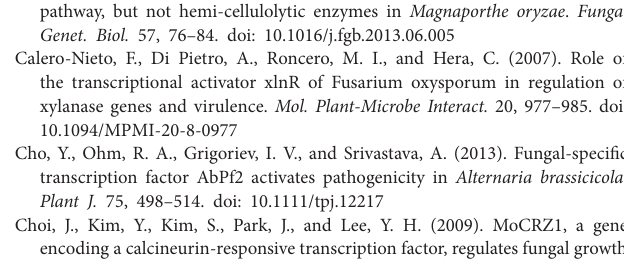
Supplementary Figure S1 | Distinct sites of the sequences predicted in transcriptomics and genomics of V. pyri . VP1G_03432 was characterized using V. pyri genomics. The sequence of VpxlnR was obtained from de novo transcriptomics. The line shown in the figure indicates the gaps of the two sequences. Supplementary Figure S2 | Constructs for VpxlnR replacement and complementation. VpxlnR deletion constructs were generated by triple joint PCR amplification (described in the “Materials and Methods” section). The arrows indicate primer sites. The numbers (1–12) represent the primers ( Supplementary Table S5 ) used for deletion construct generation and genomic PCR identification. Supplementary Figure S3 | The mutant was confirmed by genomic PCR and RT–qPCR. (A) Genomic PCR identification for fragments in replacement sites. Primer pairs with numbers are shown in the right panel, and numbers are the same as in Supplementary Figure S1 . WT, wild-type strain (Vp297); m-7 and m-56, VpxlnR deletion mutants; C-320 and C-236, VpxlnR complementation strains. (B) VpxlnR expression level in deletion mutant. Transcript levels were quantified by RT–qPCR and normalized to actin gene expression. Each test was repeat three times. The relative transcript level of the gene at time point 0 was set as 1.0. The data were analyzed using one-way ANOVA. ns indicates a value of p > 0.05, ** indicates a value of p < 0.01. Supplementary Figure S4 | RT–qPCR test of nontarget genes controlled by VpxlnR. (A) Serine/threonine-protein kinase KIN28-encoding gene (VP1G_04075); (B) serine/threonine-protein kinase GCN2-encoding gene (VP1G_10966); (C) putative phosphotransferase-encoding gene (VP1G_03516). The transcript level of each gene was normalized to actin expression. Each test was repeated three times, and the data were analysed using one-way ANOVA. ns indicates a value of p > 0.05, * indicates a value of p < 0.05, and ** indicates value of p <